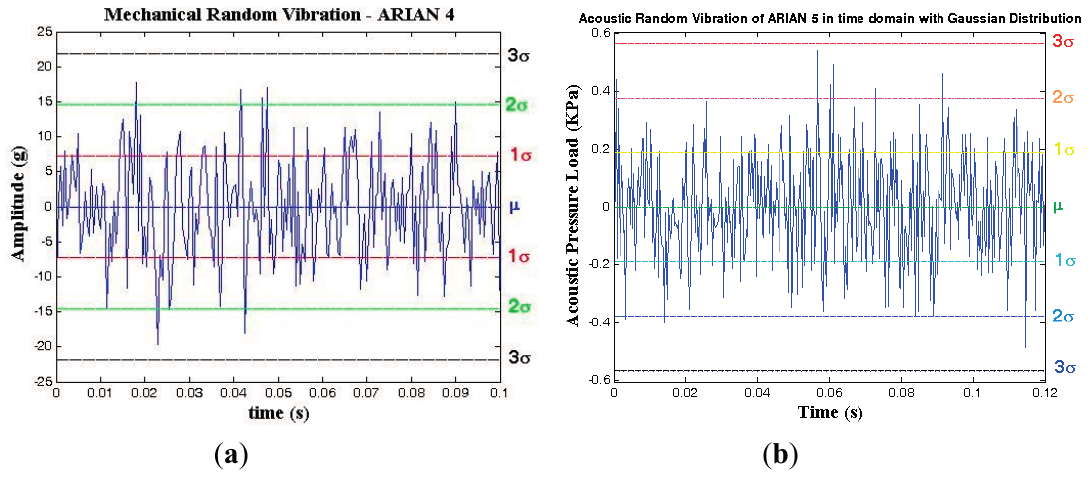
Figure 16. Time domain representation of the random vibration with the Gaussian distribution for the Arian launch vehicle. ( a ) Mechanical random vibration (20–2000 Hz); ( b ) acoustical random vibration (20–2828 Hz).